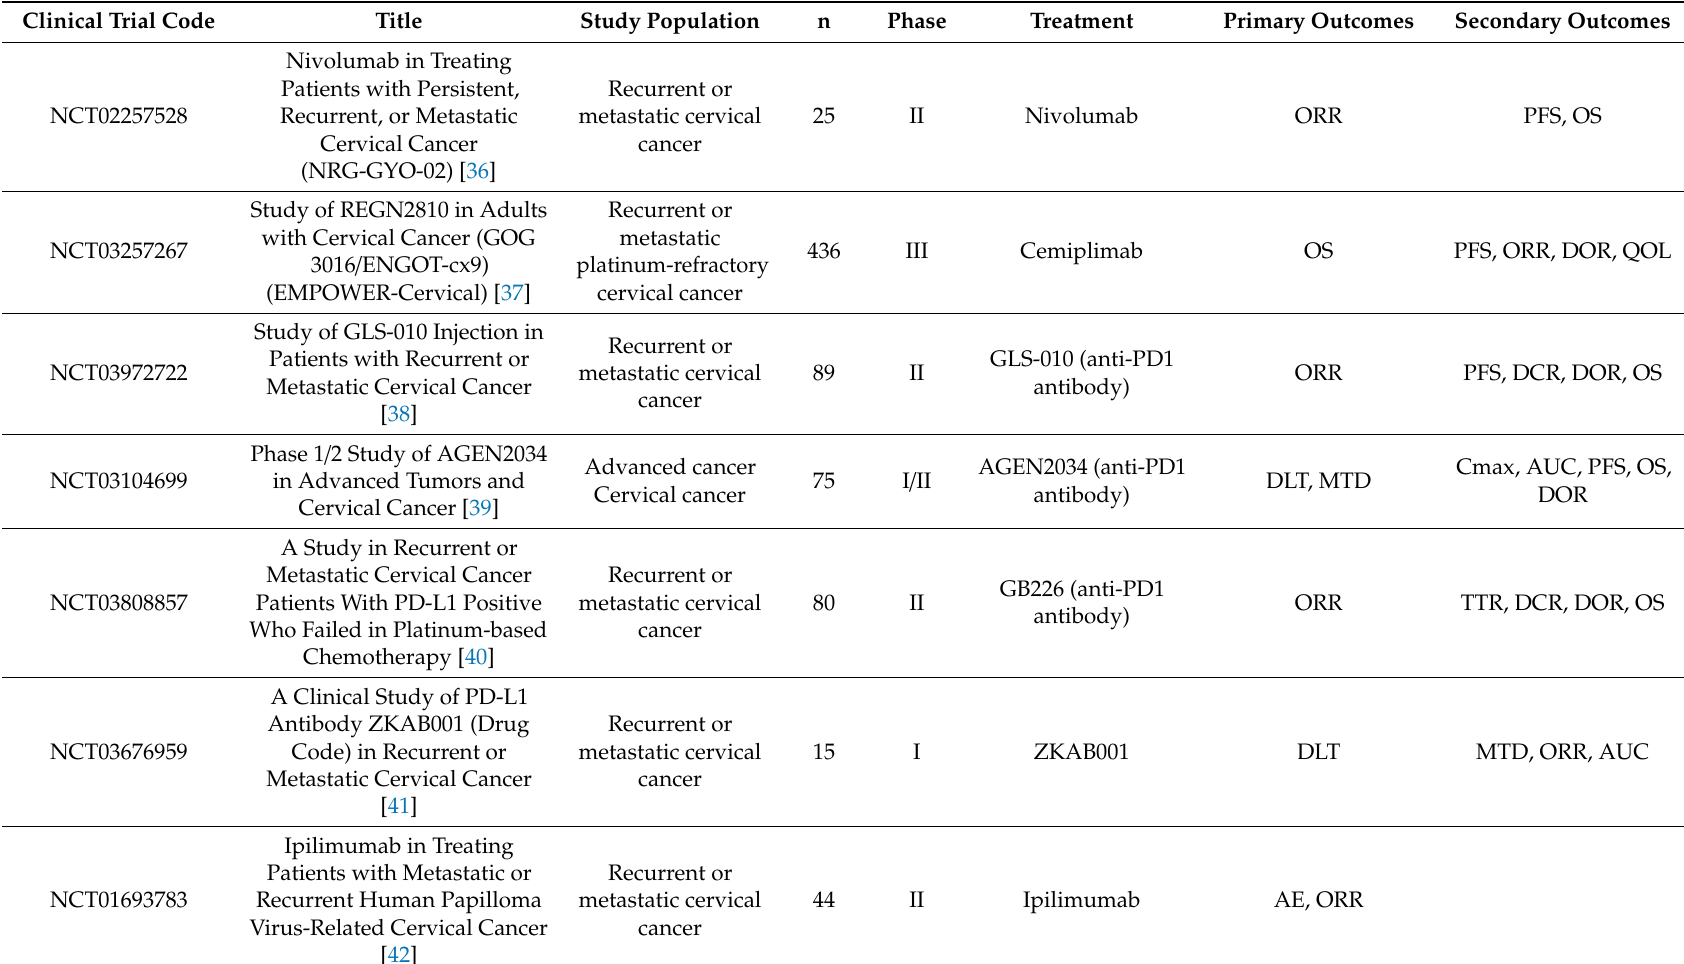
Table 2. Ongoing clinical trials of immunotherapy for cervical cancer